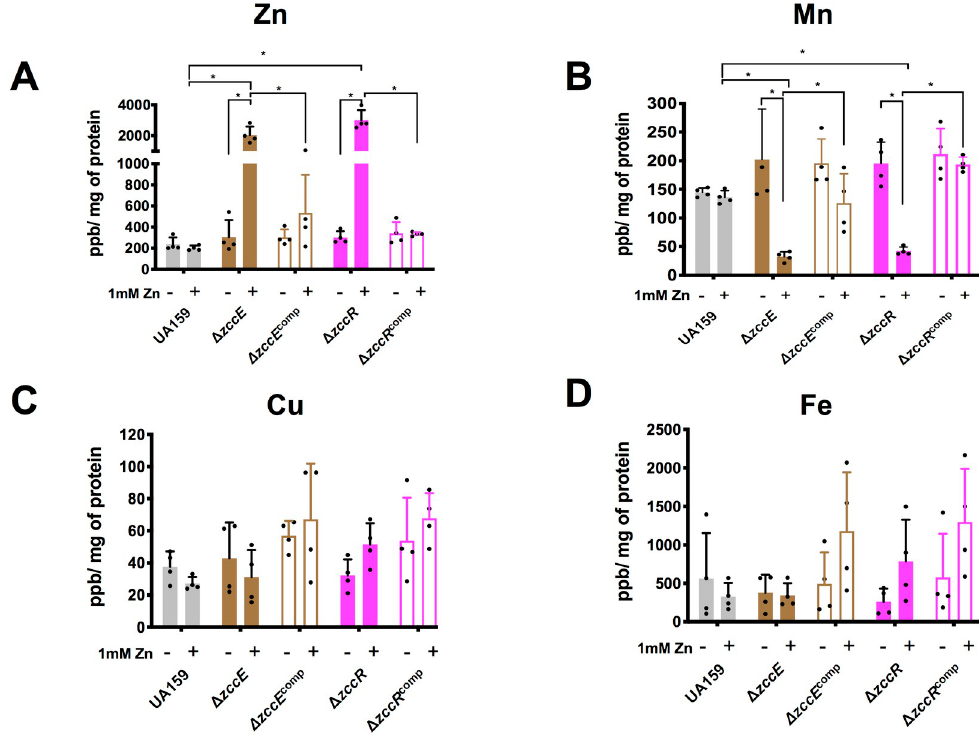
Fig 7. ICP-MS quantifications of intracellular Zn, Mn, Cu and Fe in UA159, Δ zccE , Δ zccR and respective complemented strains. Strains were grown in BHI to mid-exponential phase at which point the experimental groups were exposed to 1 mM Zn for 90 minutes. The graphs indicate intracellular parts per billion Zn (A), Mn (B), Cu (C), and Fe (D) normalized by milligram of total protein. Data represent average and standard deviation of values from four independent biological replicates. Two-way ANOVA was used to determine significance between metal content of either the same strain before and after Zn exposure or among different strains after Zn exposure. Error bars represent standard deviations of results from at least 3 independent experiments. A p value of < 0.05 was considered significant ( � ), and only comparisons that were statistically significant are indicated in the